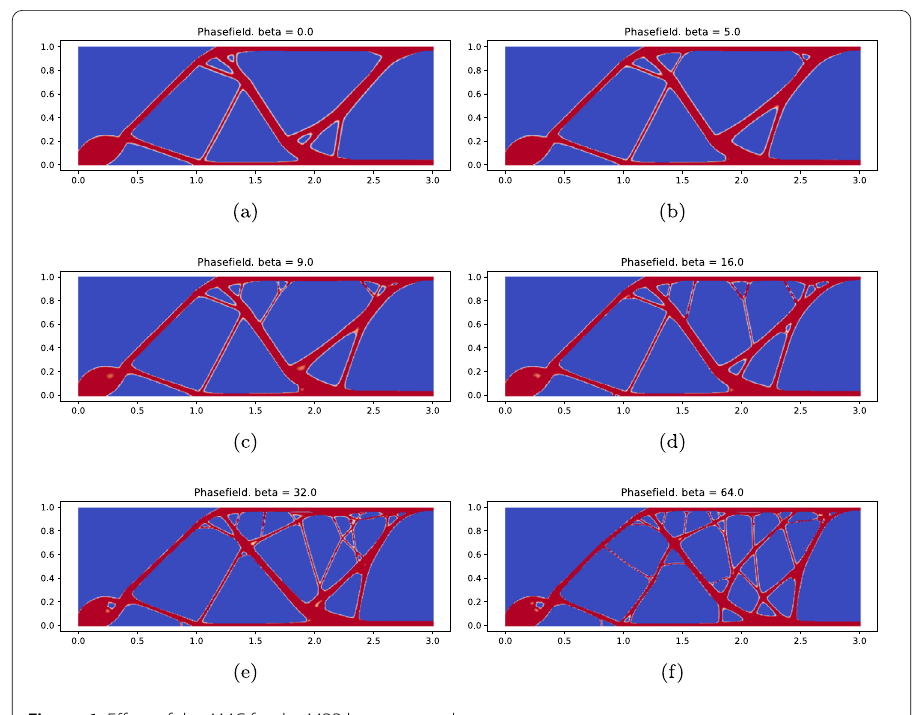
Figure 6 Effect of the AMC for the MBB beam example